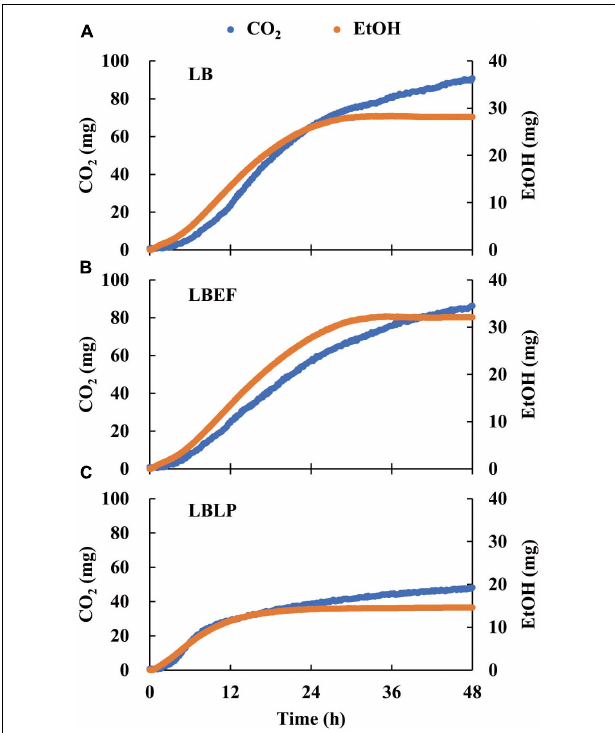
FIGURE 5 | Time courses of CO 2 and ethanol production with respect to LB (A) , LBEF (B) and LBLP (C) under anaerobic conditions. LB, Lentilactobacillus buchneri ; LBEF, LB mixed with Enterococcus faecium ; LBLP, LB mixed with Lactiplantibacillus plantarum .